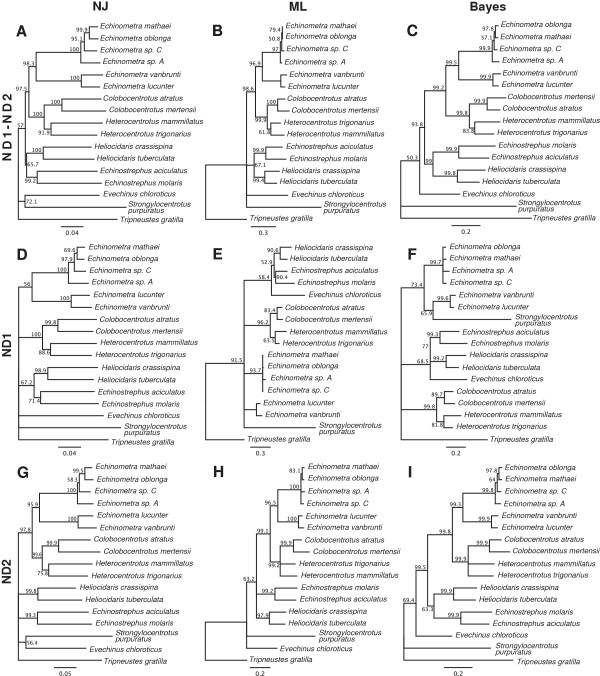
Phylogenetic trees. Resulting trees for the phylogenetic analysis of Echinometridae species based on the nucleotide sequences of ND1, ND2 and combined ND1-ND2 genes. Trees were constructed using neighbour-joining (NJ), maximum-likelihood (ML), and Bayesian inference (Bayes) methods. Numbers at each internal node represent the bootstrap percentage values for the nodes support. The scale bar represents base substitutions per site. Shown are the: ND1-ND2 NJ (A), ML (B), Bayes (C) trees; ND1 NJ (D), ML (E), Bayes (F) trees; and ND2 NJ (G), ML (H), Bayes (I) trees.